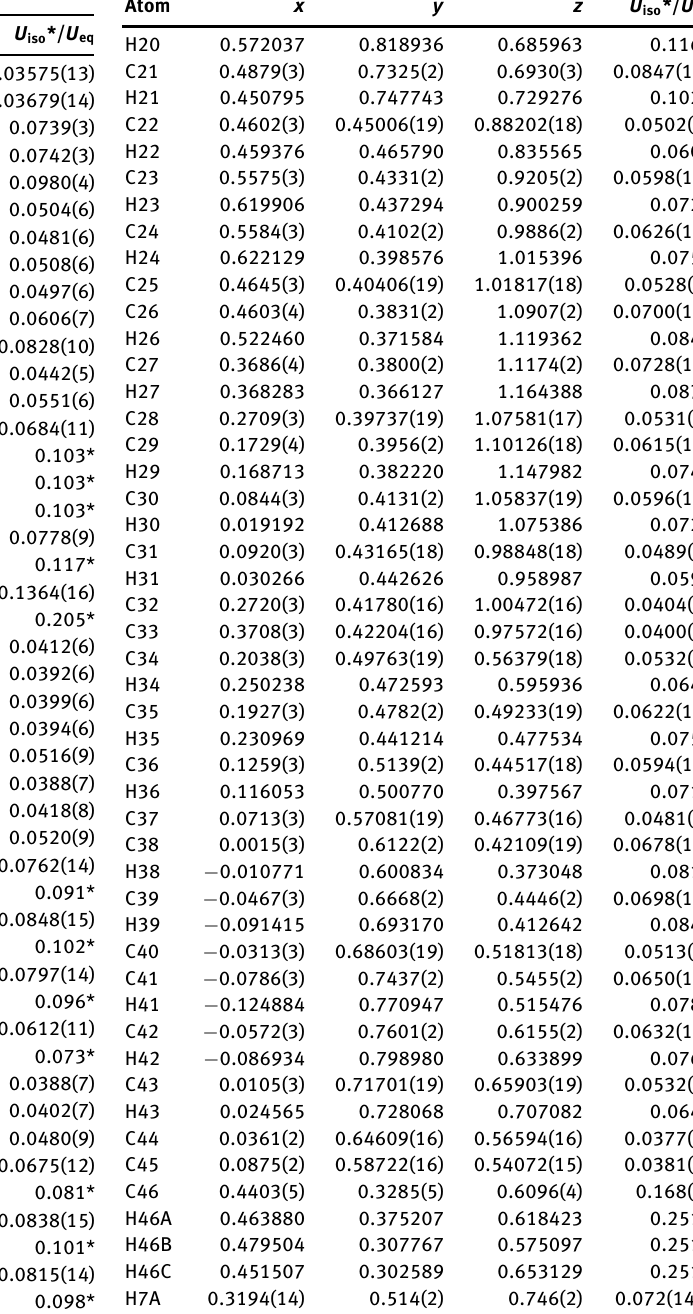
Table 2: Fractional atomic coordinates and isotropic or equivalent isotropic displacement parameters (Å 2